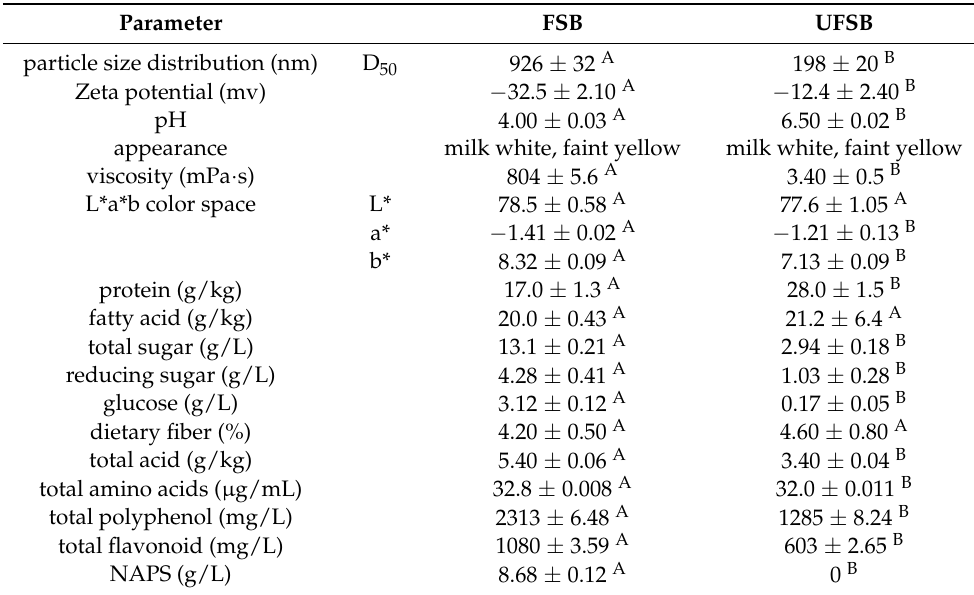
Table 1. Physicochemical parameters and nutritional ingredients of the unfermented and fermented soy beverages with N. aurantialba